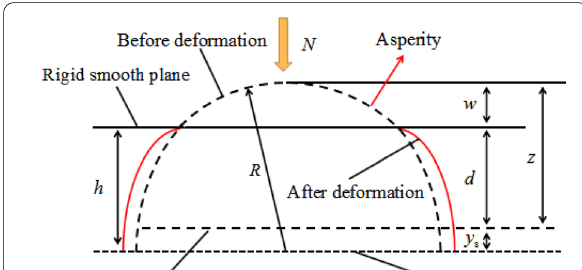
Fig. 5 Normal contact model between a single asperity and a rigid smooth